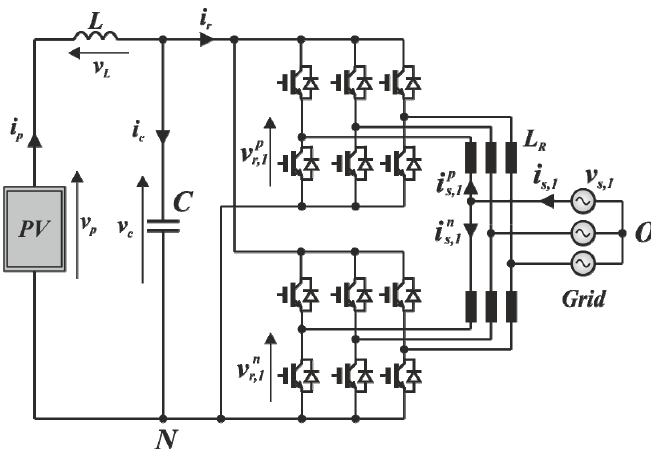
Figure 1. Topology of the grid connected photovoltaic generation system via an interleaved inverter.